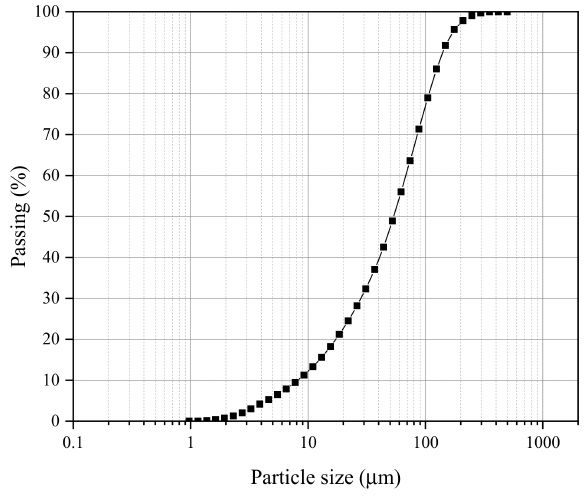
Figure 2. Particle size distribution of dredged sludge. Table 2. Chemical compositions of dredged sludge, CCR and Portland cement.